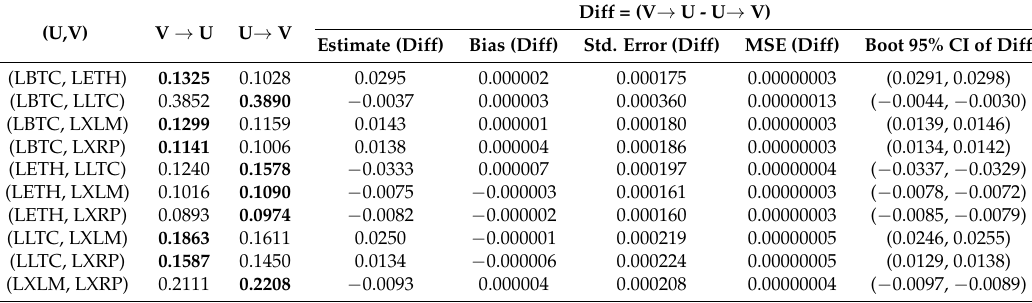
Figure 2. Residuals from neural network autoregression NNAR models to the daily log-returns in percentage of the five cryptocurrencies. Table 4. The results of copula directional dependence. The higher value of copula directional dependence between each direction is highlighted in